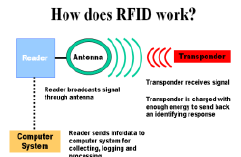
Figure 1 : Working of RFID Technology